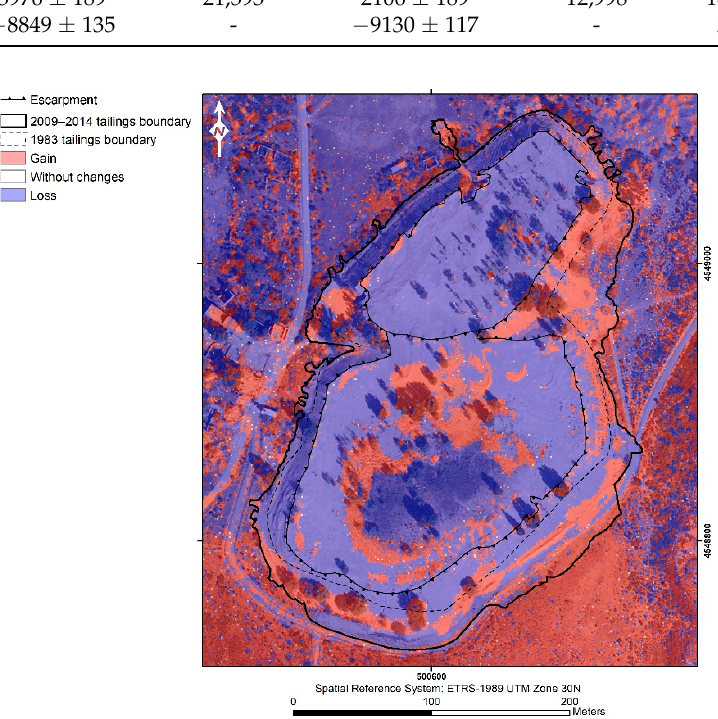
Figure 8. Sludge loss and gain distribution map between 2009 and 2014. Table 4. Sludge loss and gain between 2009 and 2014 expressed in volume (m 3 ) and area (m 2 ), with the breakdown of values inside (1983 contour) and outside (surrounding area) the 1983 boundary of the ponds.